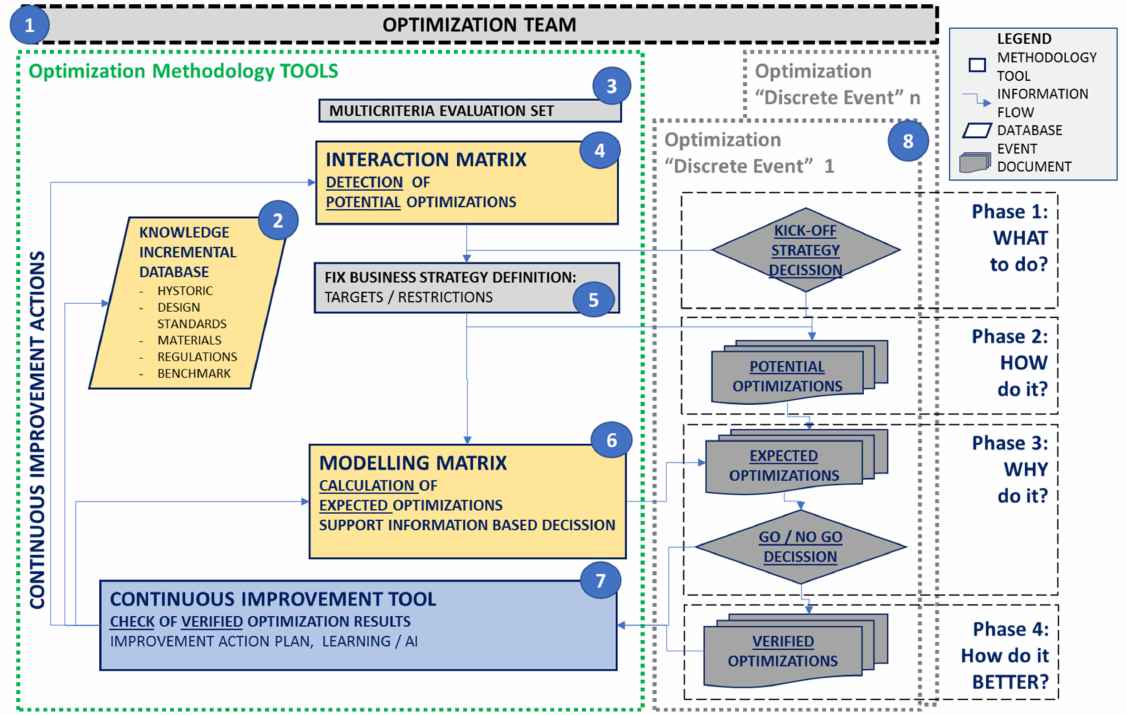
Figure 4. Detailed flowchart of methodology: phase and tool